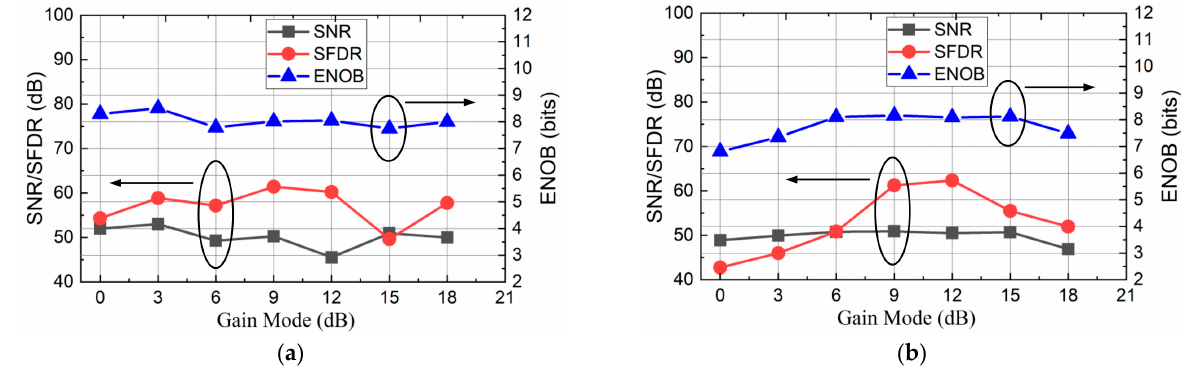
Figure 13. Measured dynamic performance versus different gain modes for low-frequency input at: